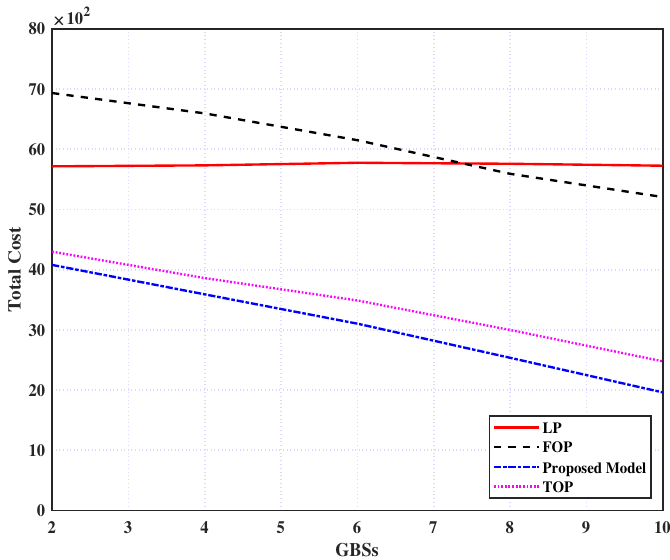
Figure 8. A comparison of total cost for different numbers of GBSs (K = 5, N = 3).